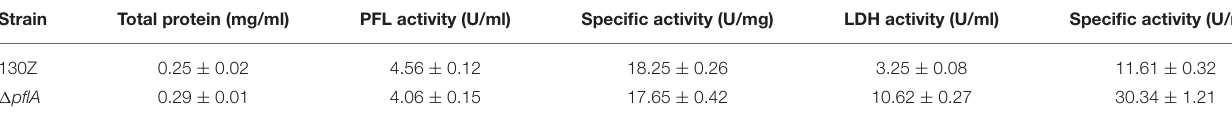
TABLE 1 | Comparison of enzyme activities involved in organic acid formation in Actinobacillus succinogenes 130Z and 1 pflA grown anaerobically.